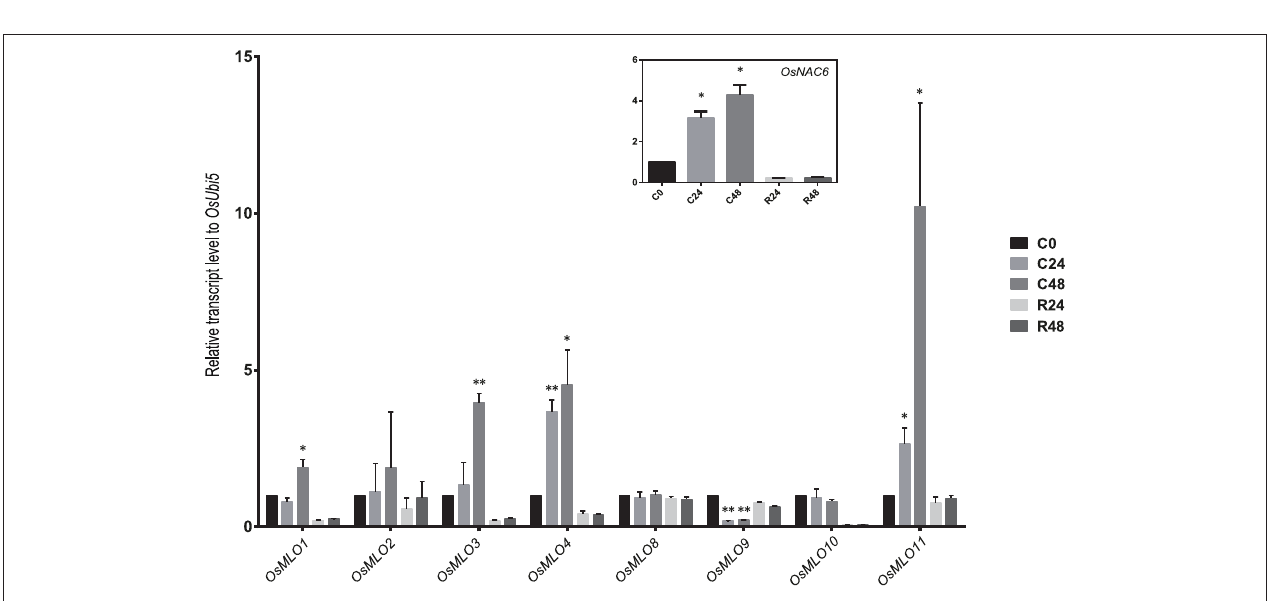
FIGURE 7 | Expression profiles of OsMLO genes under heat stress evaluated by real-time PCR analysis. OsHsp1 served as a positive marker for heat-stress response. OsUbi5 was used as internal control. M, control treatment; H, high-temperature treatment. Numbers after M and H indicate time points (hours) after stress treatment. ** p < 0.01; *0.01 < p < 0.05.